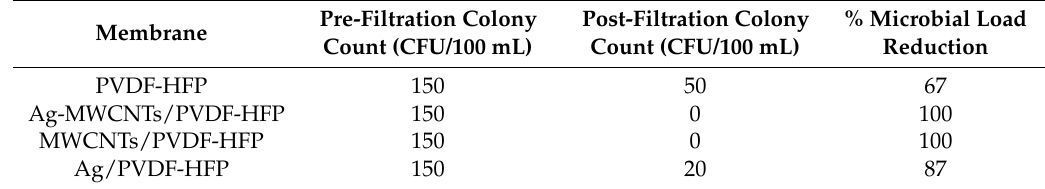
Table 2. Effects of membrane compositions on filtration of E. coli .